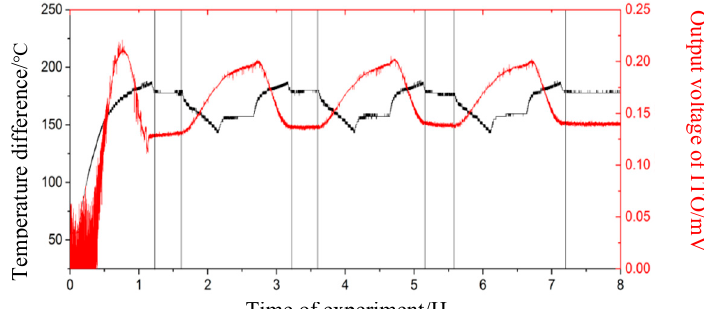
Figure 11. Relationship between the temperature difference and output voltage.